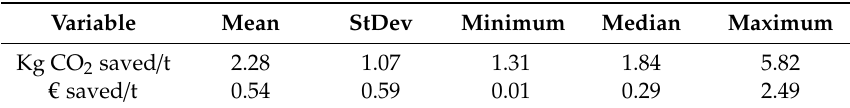
Table 5. Potential savings in kg CO 2 / t and € / t for CO 2 -beneficial and terminal supportive transports over the